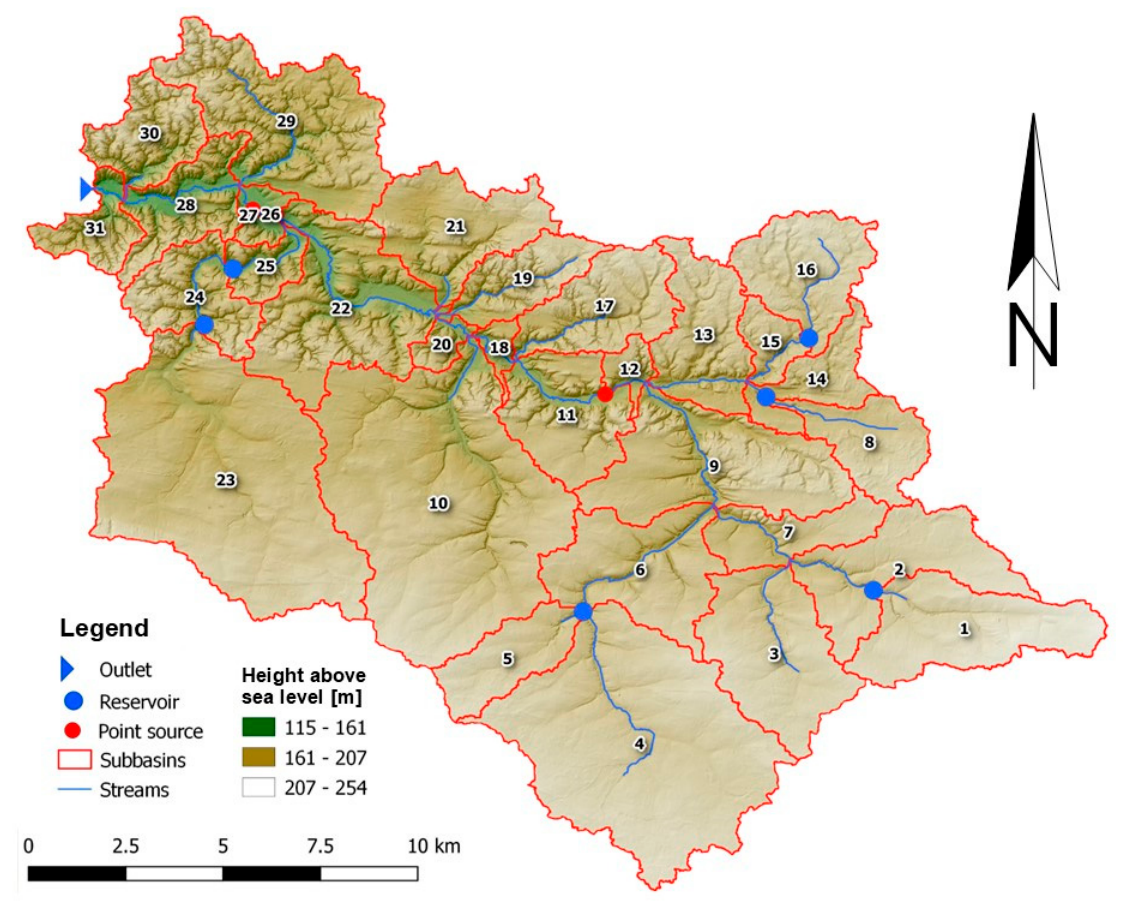
Figure 6. Study area: Bystra River basin with marked main tributaries and their catchments (own study).